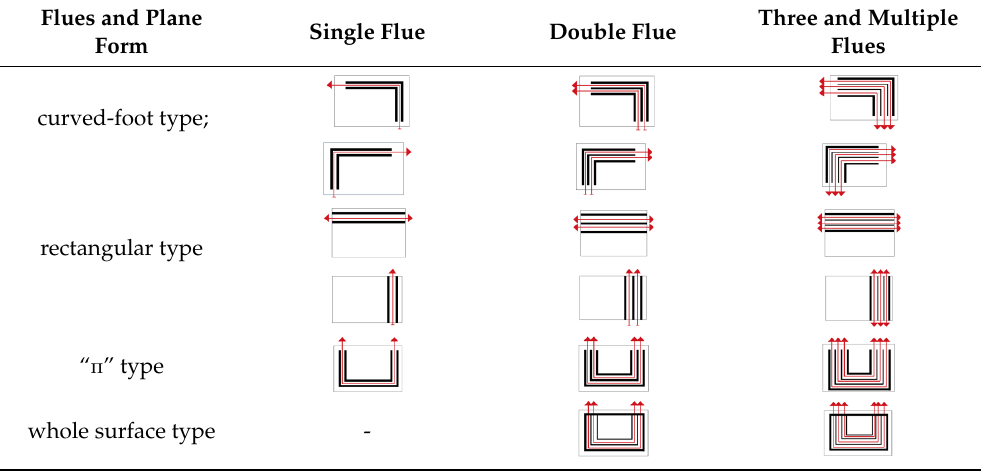
Table 6. The heated kang relics of different periods in the Amur river basin [28 – 33].